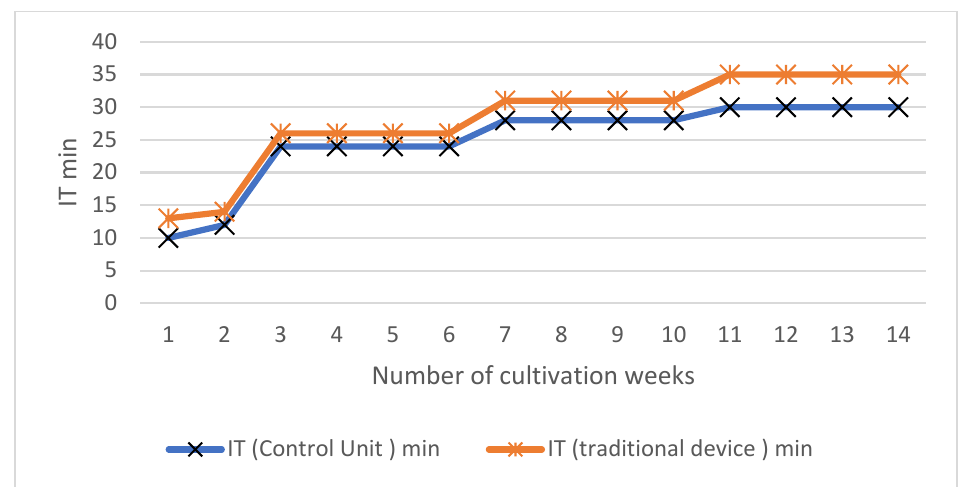
Figure 4. Results of WCR from an Arduino microcontroller system and traditional devices by week.